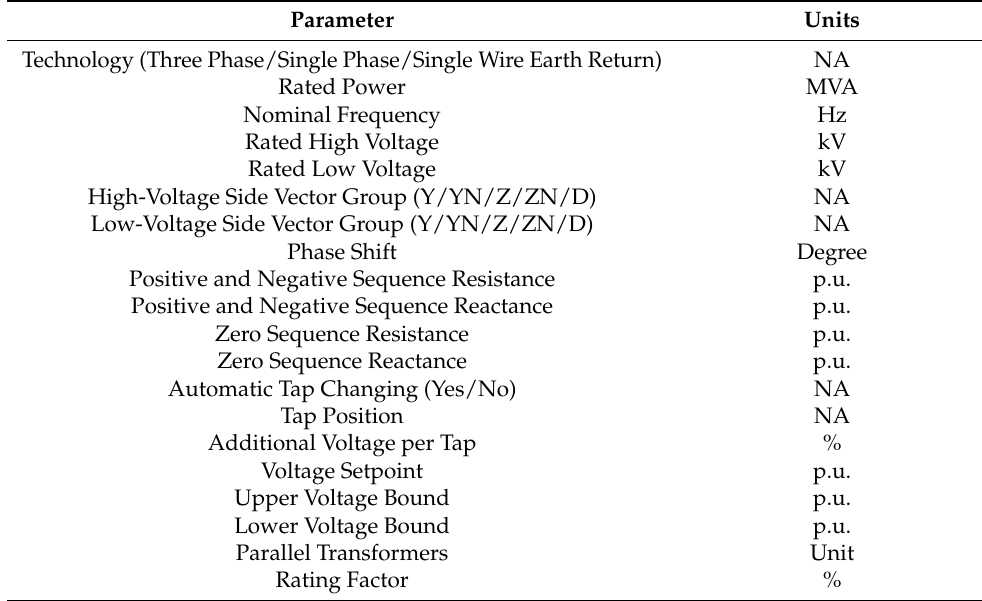
Table 2. Input parameters to model transformers.